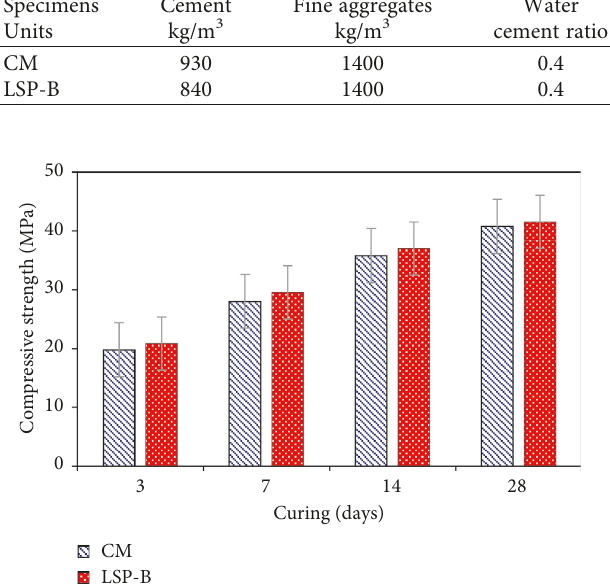
Figure 4: Compressive strength of mortar formulations with and without immobilized microbes at different curing ages.